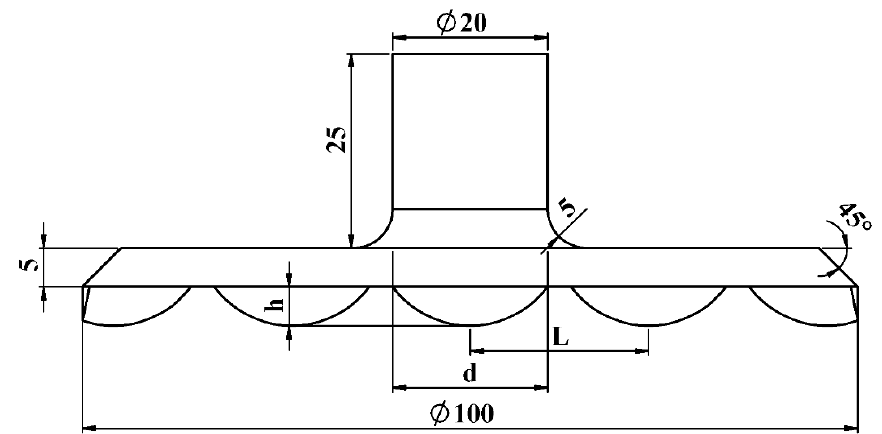
Figure 2. Structural diagram of the test disc (dimensions in millimeters).